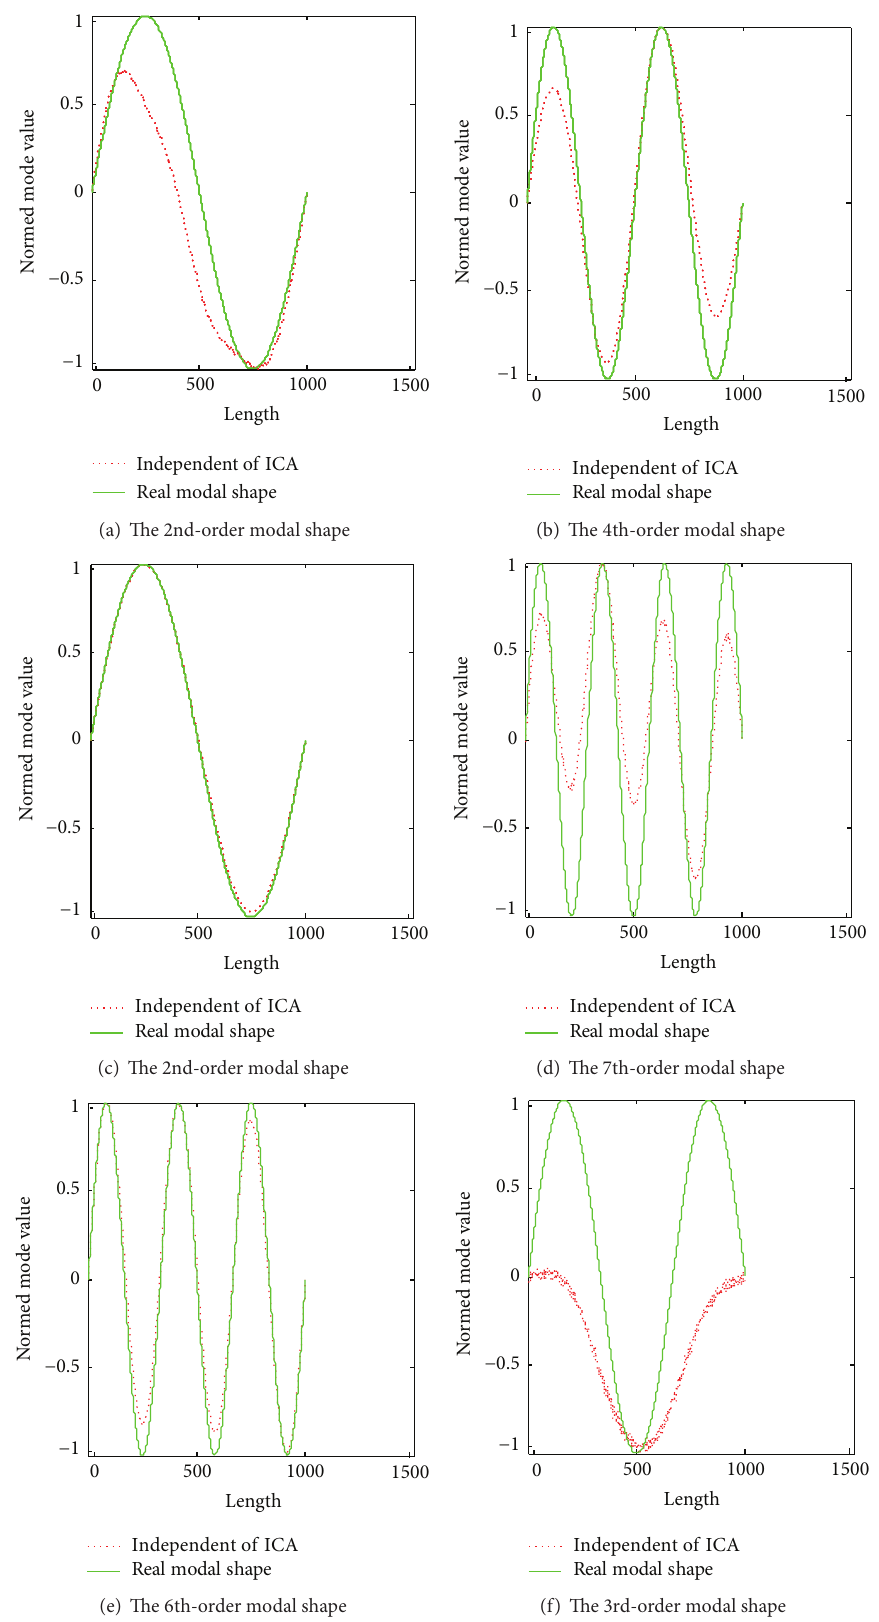
Figure 16: Modal shape comparison between FEA and separating vector by maximization negentropy with quasi-Newton iteration method with measurement